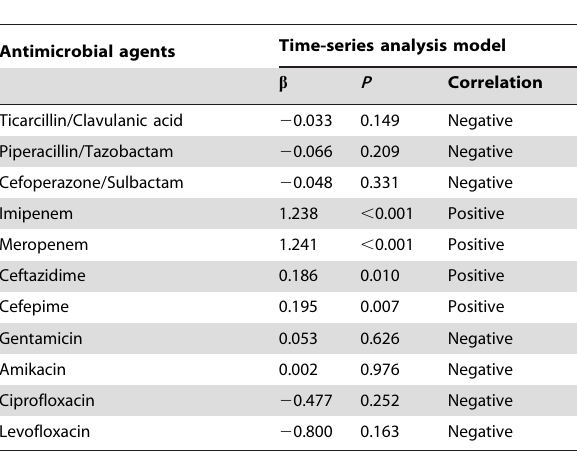
Table 3. Correlation between resistance rates of P. aeruginosa isolated from patients with HAIs and usage of antimicrobial agents in First Hospital of Jilin University, 2003–